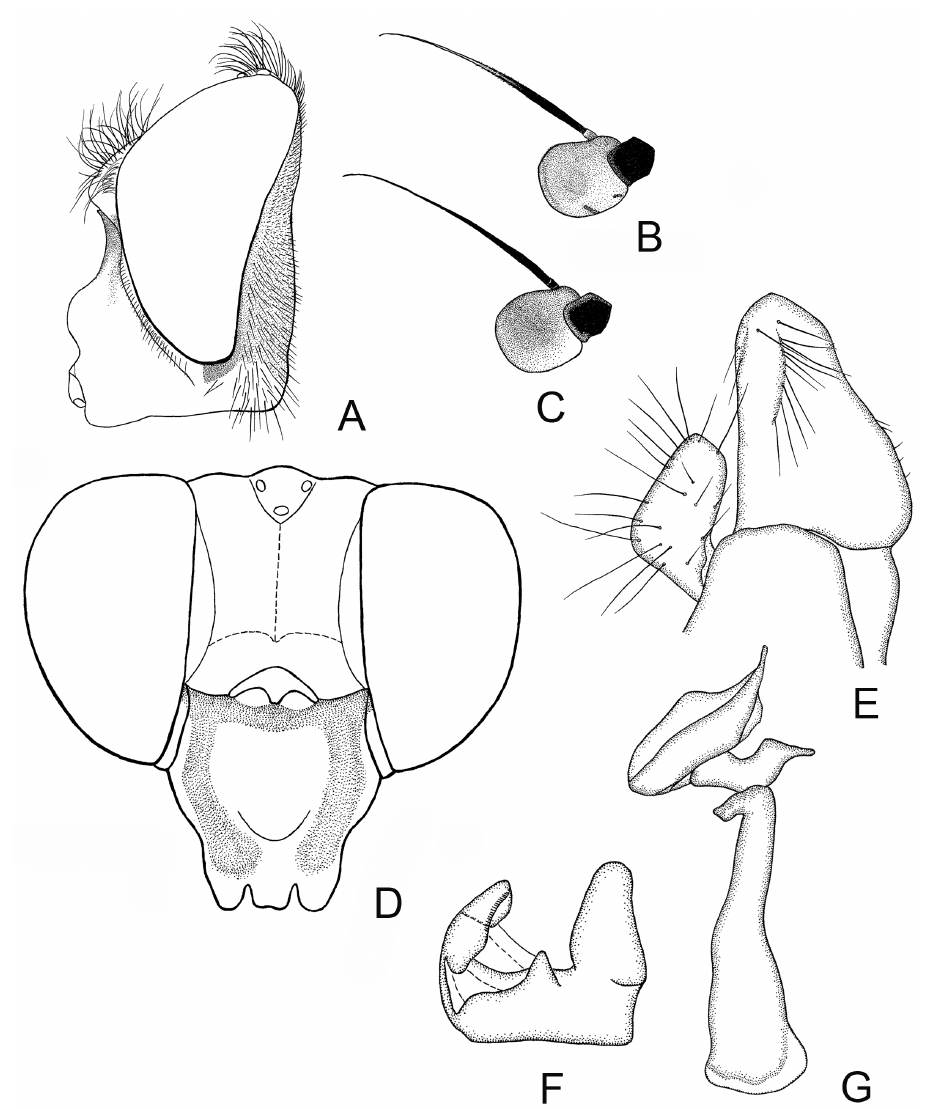
Figure 5. Cheilosia caerulescens calculosa Skufjin, male. A Head of male, lateral view B Antenna of male lateral view C Antenna of female lateral view D Head of female dorsal view E–G male genitalia, lateral, from left to right: E Cercus+surstylus F Superior lobe G Aedeagal complex yellow pile. Sternite I and IV with pollinosity, sternites II–III shining. Genitalia as in Fig. 5E–G. Female : Face as in male, parafacia shining, narrow, about 1/3 of width of basoflag- ellomere. Frons comparatively broad with two furrows (Fig. 5D). Vertical triangle